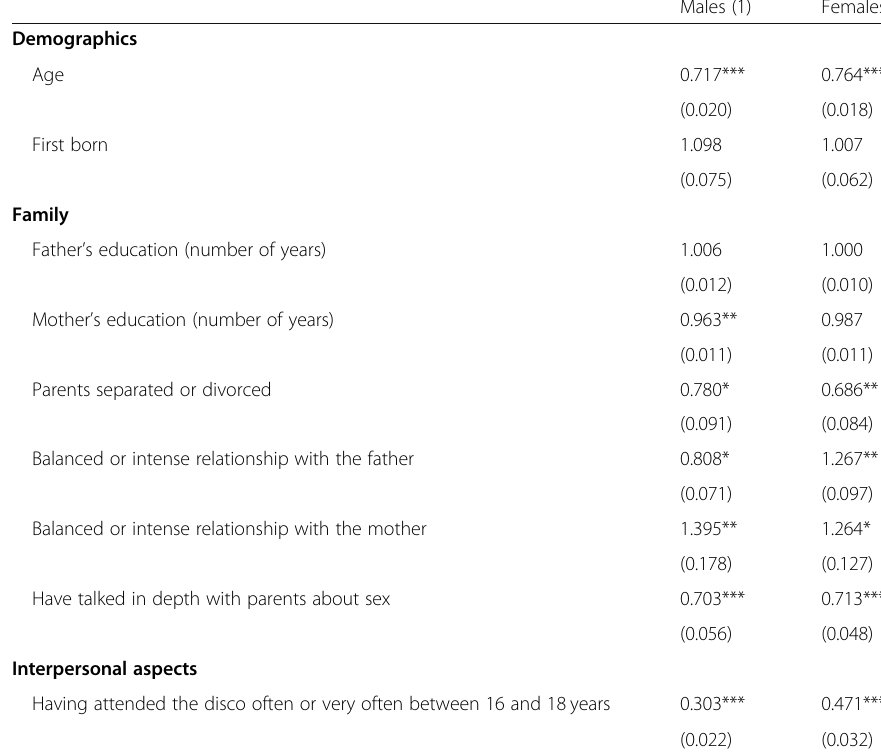
Table 1 Correlates of virginity status among Italian students, odds ratios